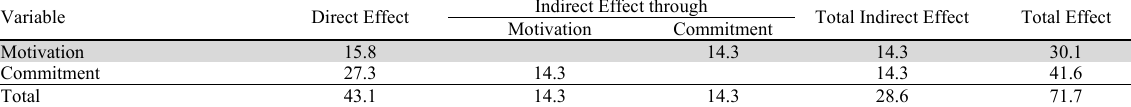
Direct and indirect effects of Motivation and Commitment toward Performance